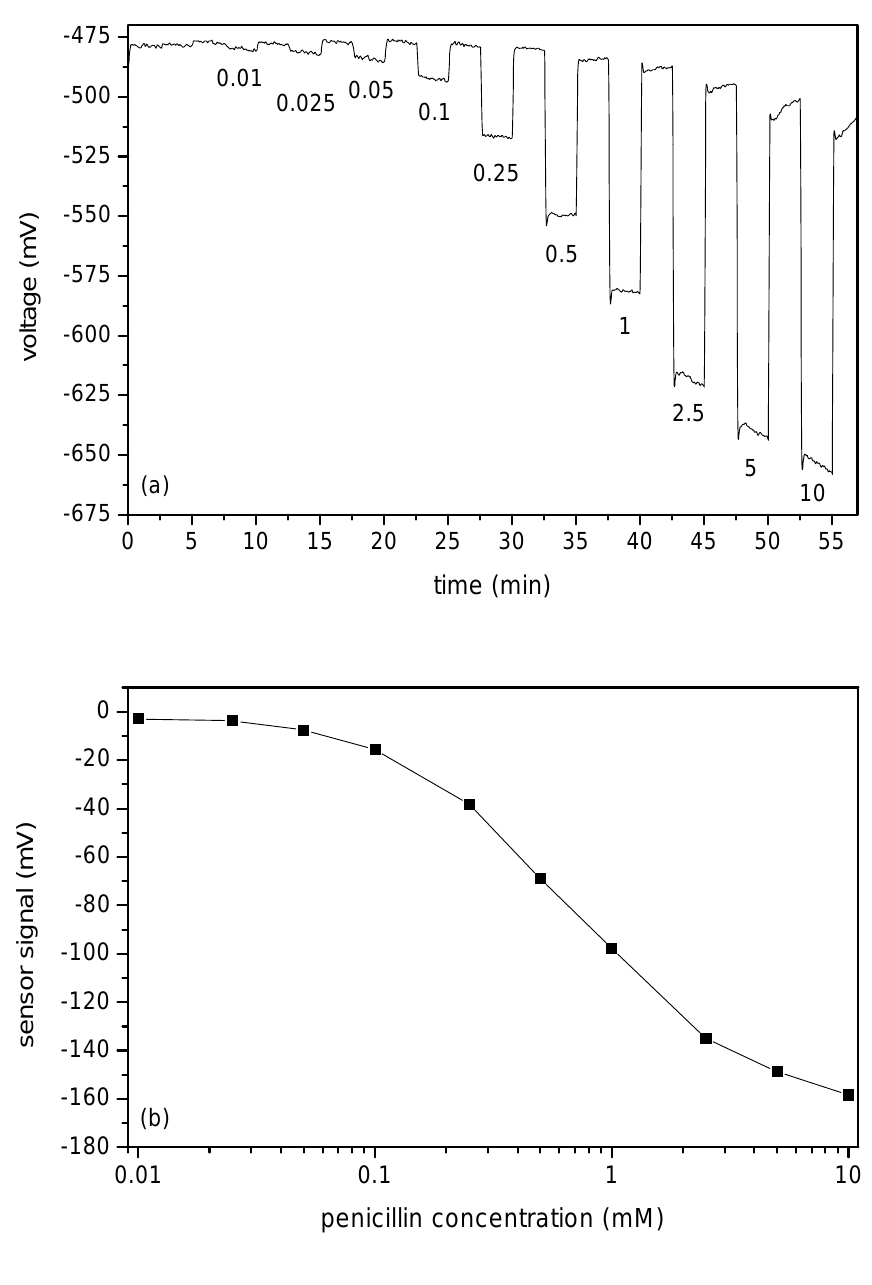
Figure 7. ConCap measurement (a) and corresponding logarithmic calibration curve (b) of a porous penicillin biosensor, etched with a current density of 20 mA/cm 2 . The sensitivity was calculated to about 85 mV/pPen in the concentration range between 0.1 mM and 1 mM penicillin